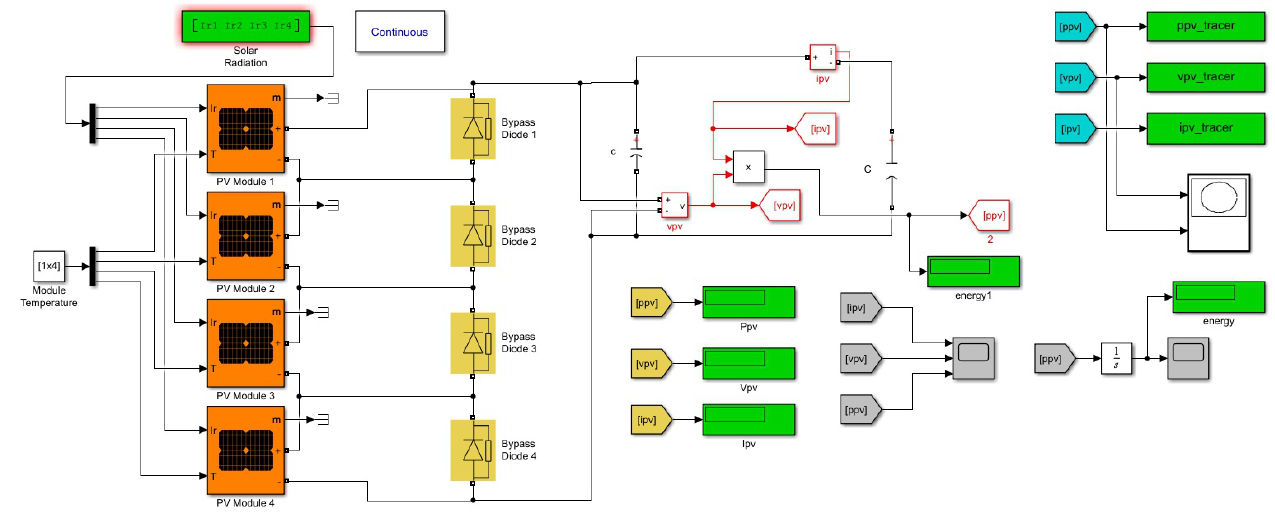
Figure 9. Simulink model of curve tracer for centralized PV system.